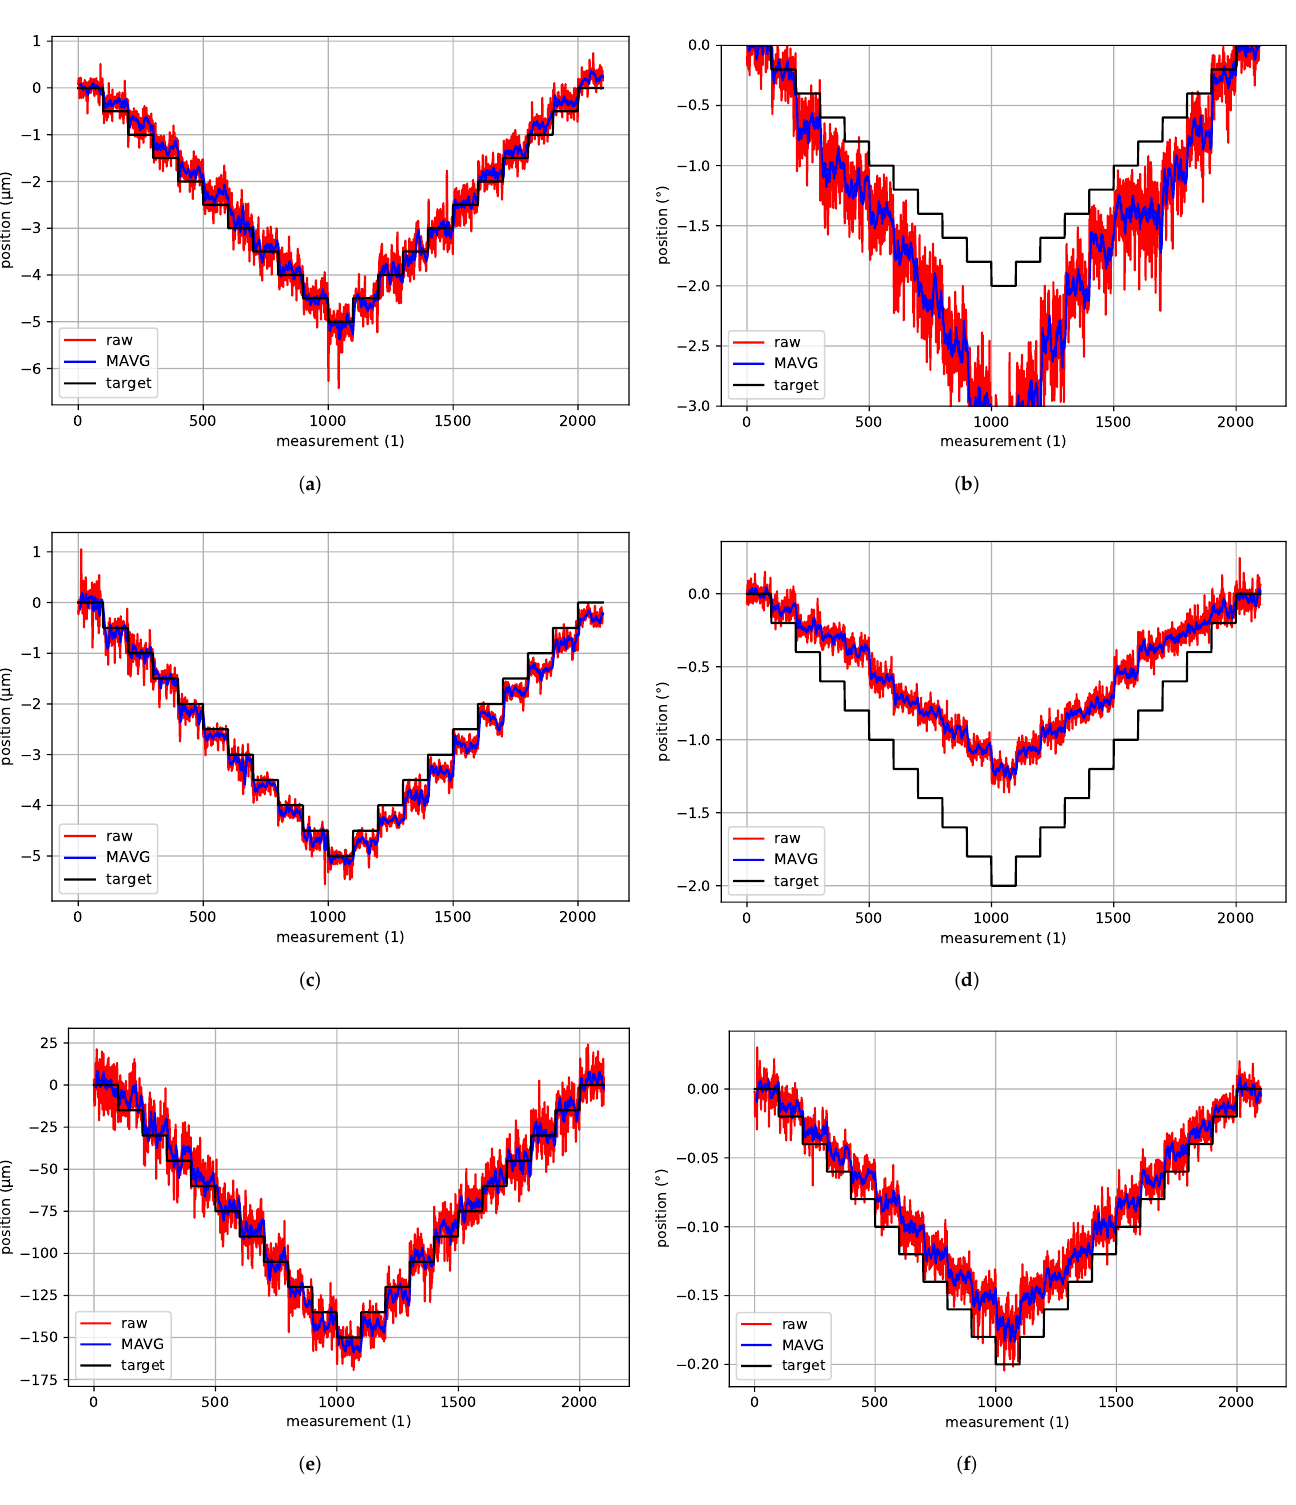
Figure 18. Experimental evaluation of the minimal incremental motion evaluation: Target (black), raw (red), and moving average (blue) values for given step sizes S obtained with the proposed direct and absolute vision-based pose measurement system: ( a ) Translation x -axis with S = 0.5 µm, ( b ) Rotation x -axis with S = 0.2 ◦ , ( c ) Translation y -axis with S = 0.5 µm, ( d ) Rotation y -axis with S = 0.2 ◦ , ( e ) Translation z -axis with S = 15 µm, ( f ) Rotation z -axis with S = 0.02 ◦